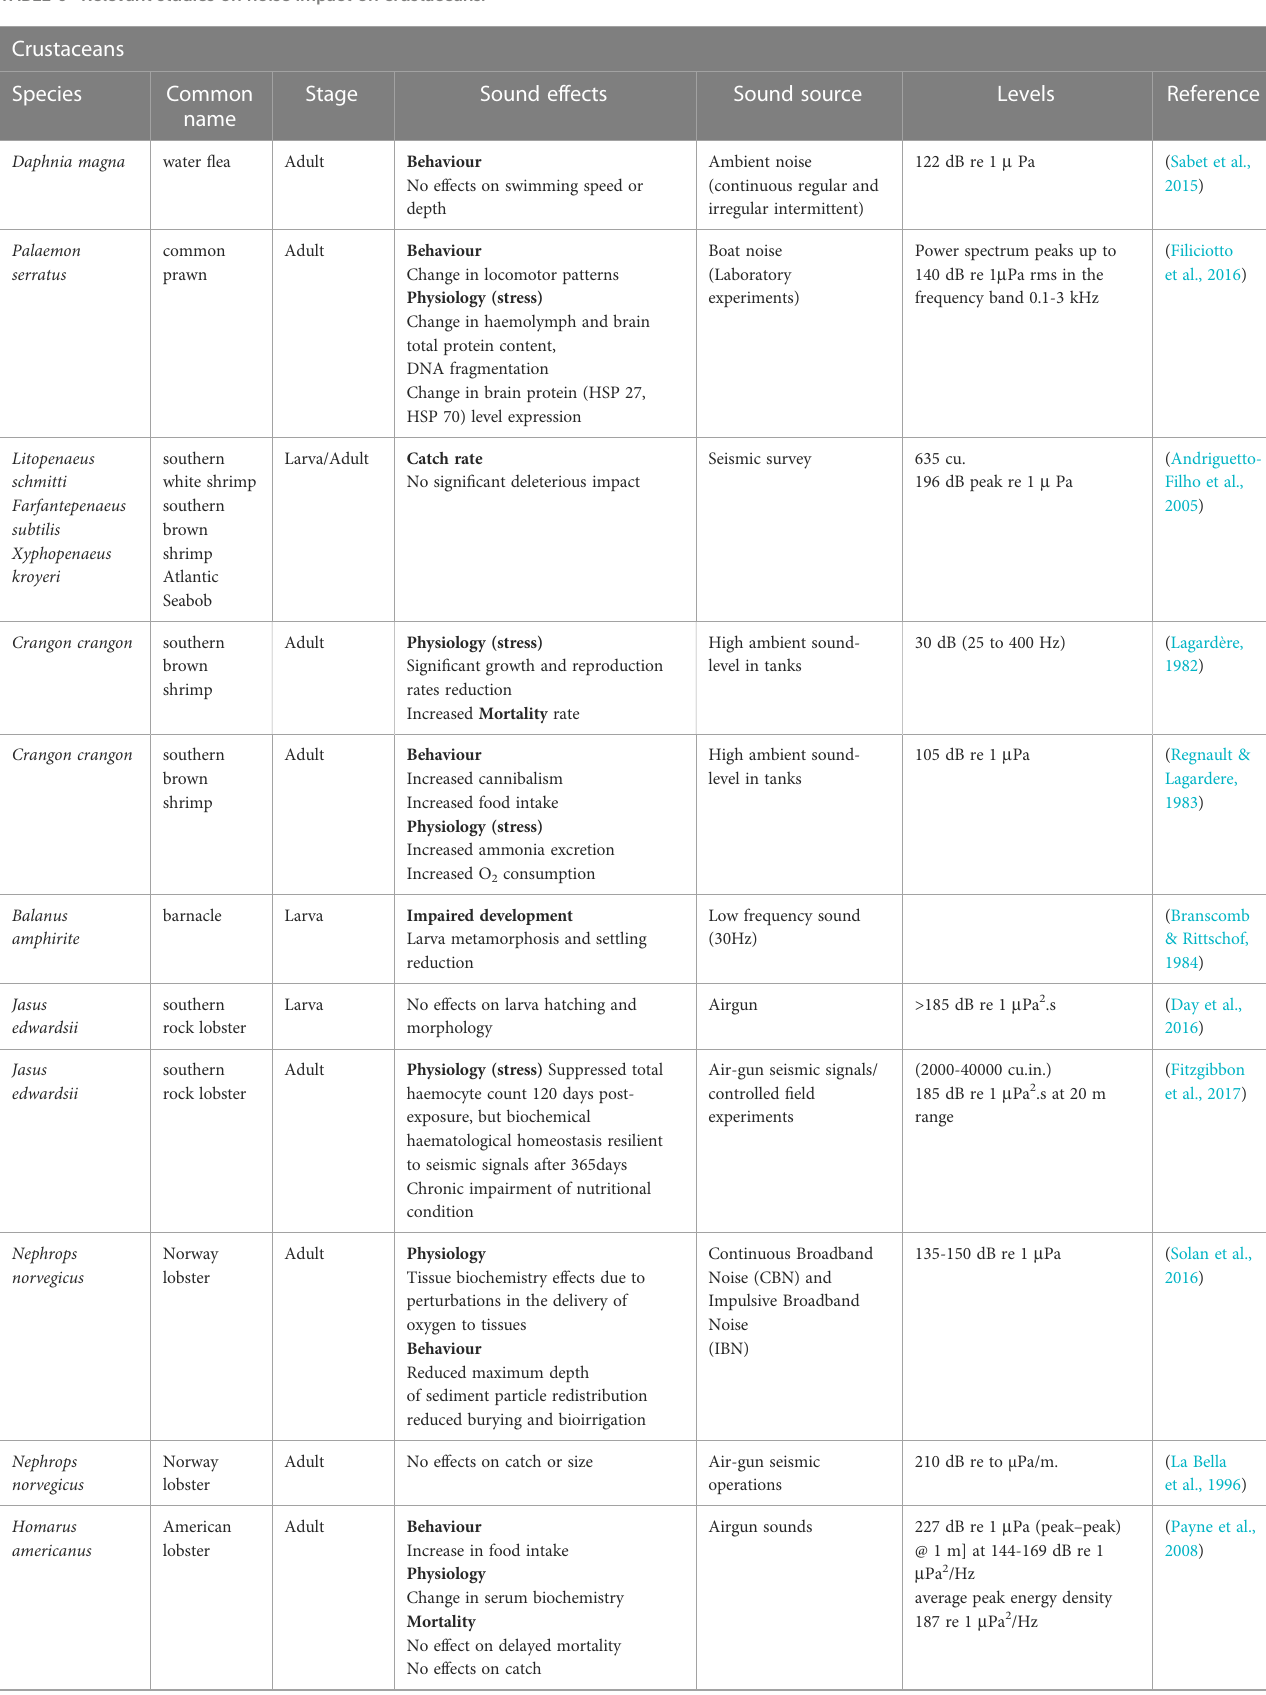
TABLE 6 Relevant studies on noise impact on